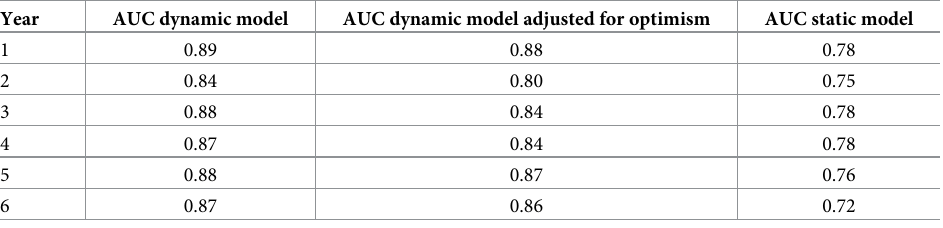
Table 4. Validation personalized risk estimation model: 1) area under the curve (AUC) of the dynamic model (= joint model), 2) AUC of the dynamic model, adjusted for optimism, 3) AUC of the static model (= Cox model). All estimates were measured at time points year 1, 2, 3, 4, 5, and 6.